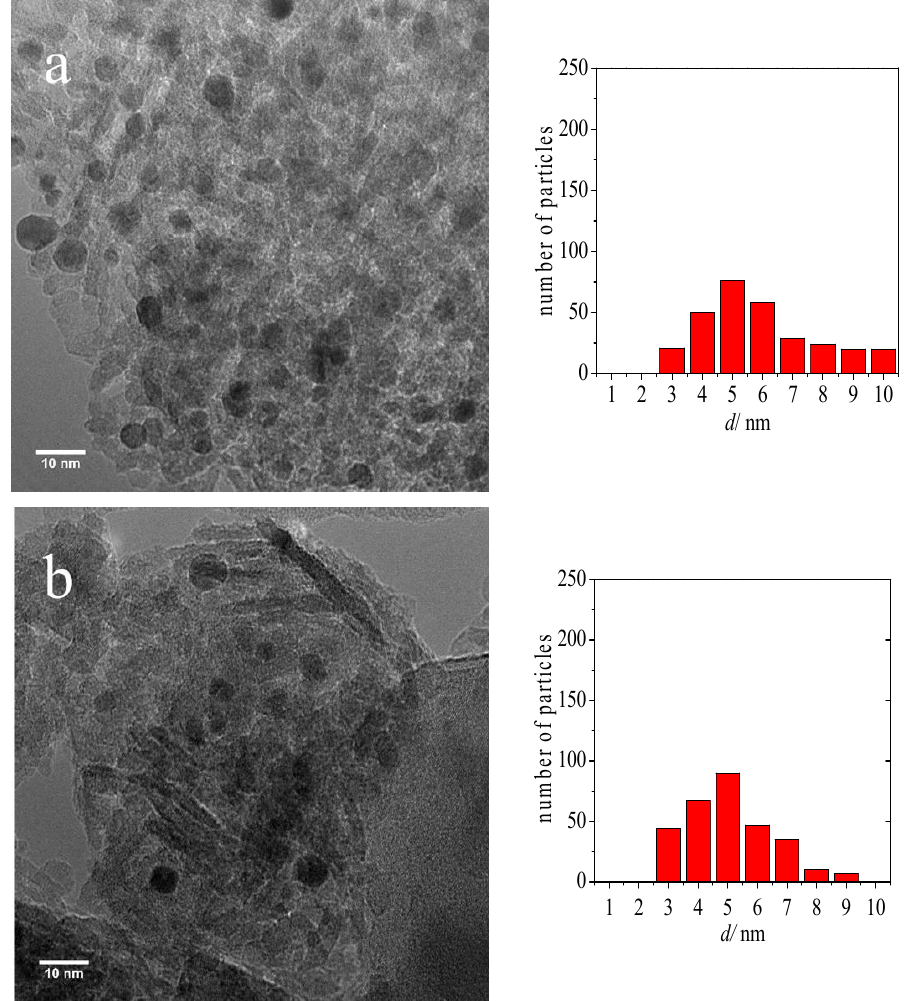
Figure 3. TEM images (right) and particle size distributions (left) of post ‐ CO oxidation of ( a ) Au ‐ DDA/ γ‐ Al 2 O 3 ; and ( b ) Au ‐ DDA/ γ‐ Al 2 O 3 (O 3 8 h). Table 1. Au particle size from TEM.